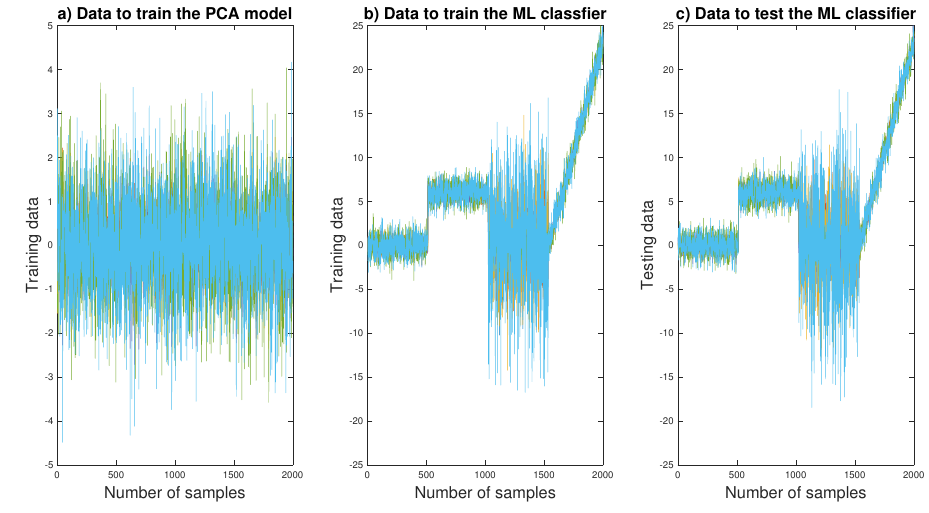
Figure 2. Data generation of numerical